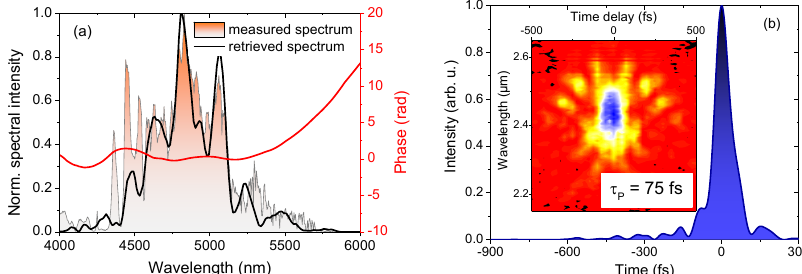
Fig. 2. SHG- FROG characterization of the 5 μm OPCPA pulses. (a) Optical spectrum, measured and retrieved (black). Phase (red); (b) retrieved temporal pulse shape (blue) and retrieved SHG-FROG trace